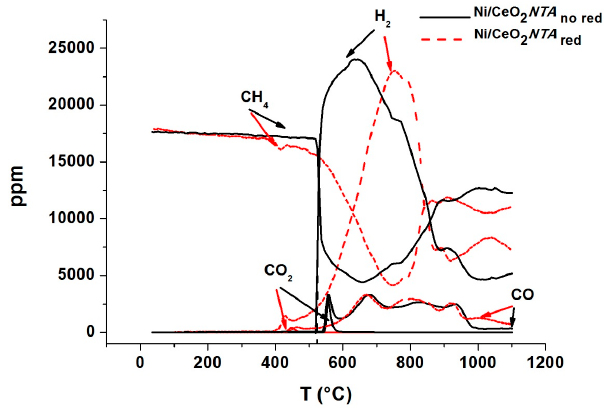
Figure 4. Comparison of CH 4 -TPSR over NiCeO 2 NTA after different pre-treatment.